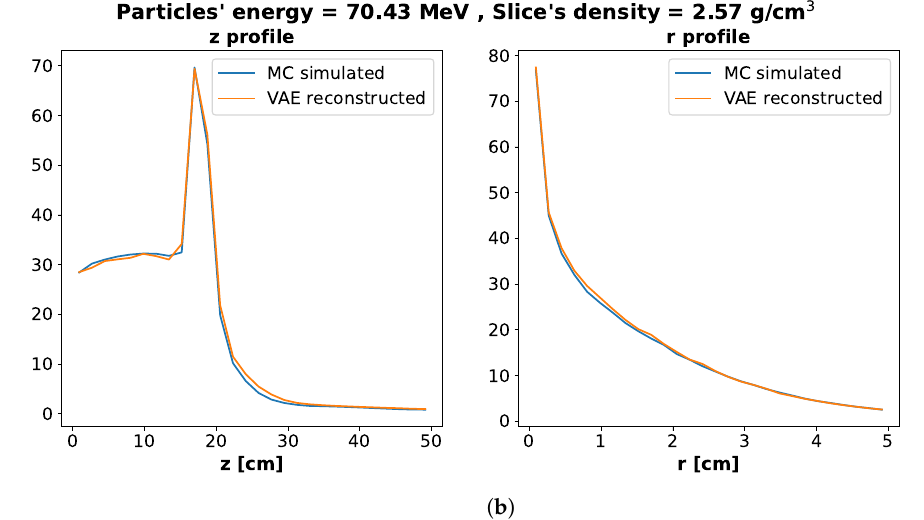
Figure 5. Energy profiles reconstruction . Distribution of energy deposition along z and r axes from the test sets of the Water dataset ( a ) and the Water + Slab dataset ( b ). The blue lines correspond to the Monte Carlo simulated data, while the orange lines refer to the reconstructed data from our Network.